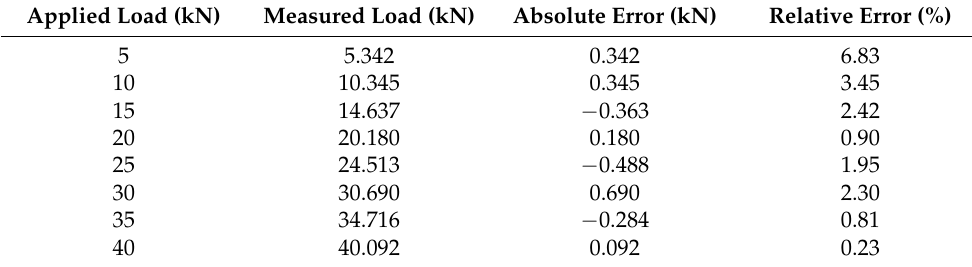
Table 3. WIM test Table 3. WIM test data.